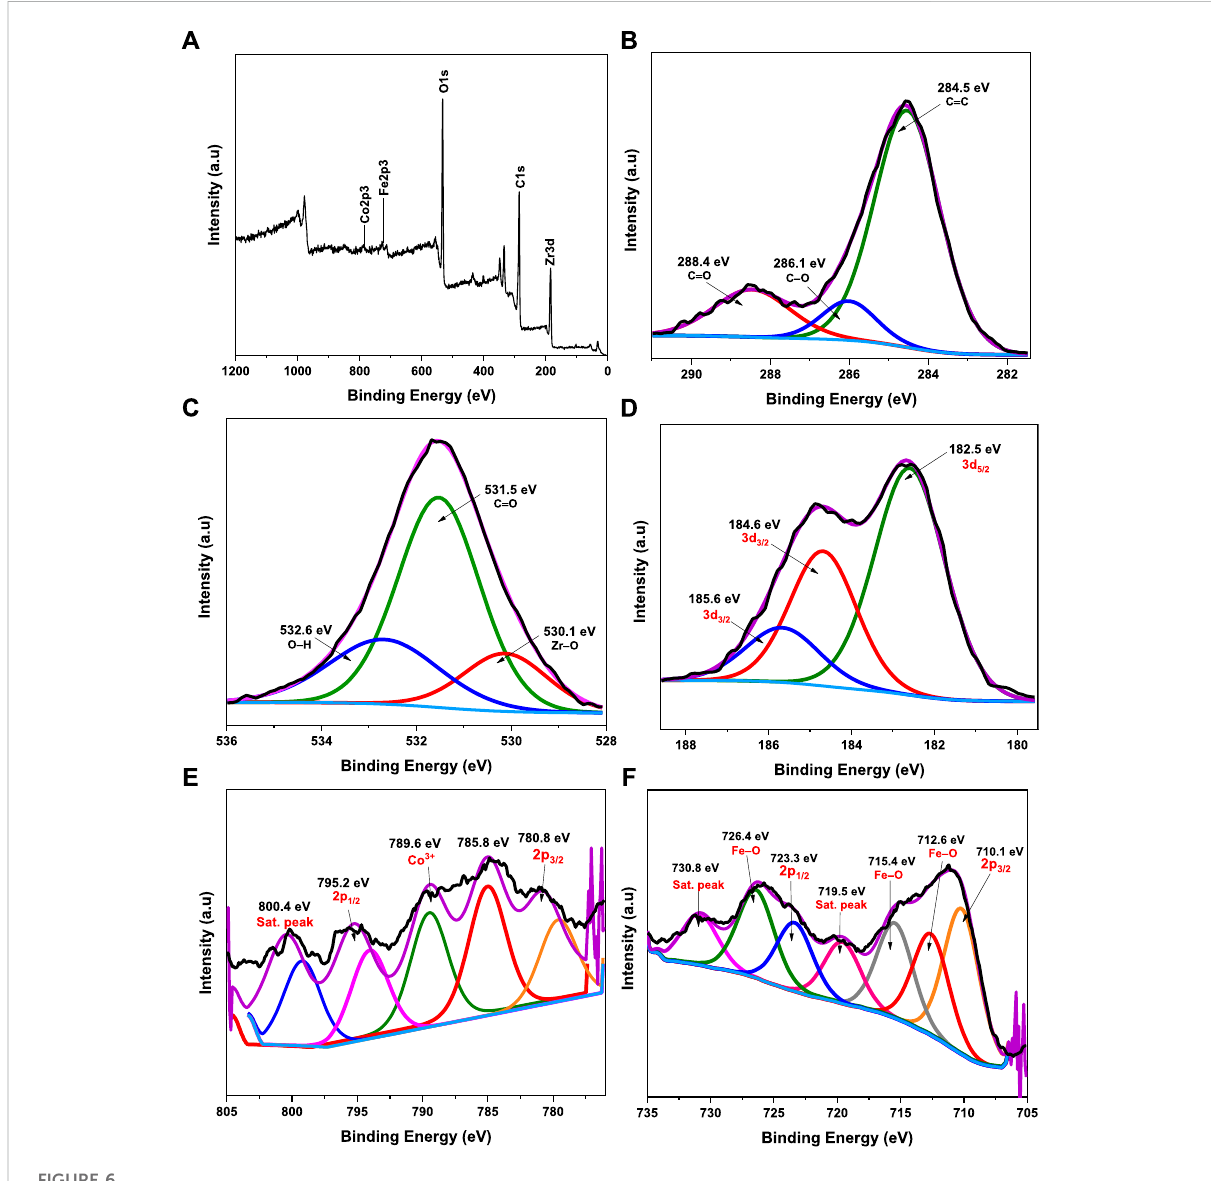
FIGURE 6 XPS spectra of CoFe 2 O 4 @UiO-66 composite: survey scan (A) , C 1s (B) , O 1s (C) , Zr 3 days (D) , Co 2p (E) , and Fe 2p (F)